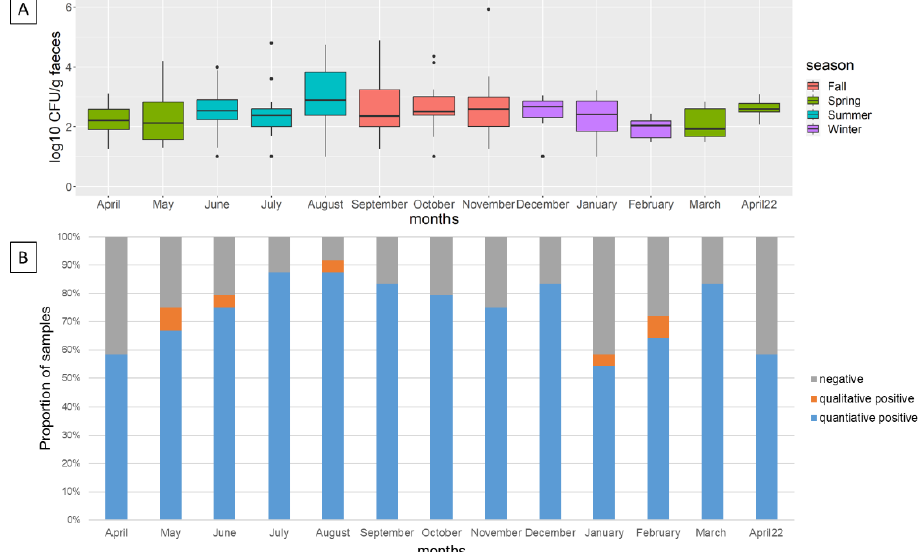
Figure 1. ( A ) Concentration of Campylobacter spp. in feces per month. ( B ) Proportion of negative, qualitative positive (enrichment) and quantitative positive samples. The concentration of Campylobacter spp. in the feces of individual cows over time is depicted in Figure 2 and Table S2. Occasionally, no Campylobacter spp. were detected in individual cows. All cows carried Campylobacter spp. in at least two samples. Cow 4317 only tested positive for Campylobacter spp. on two consecutive sampling occasions in July. Cows 4320, 4659 and 6005 were always